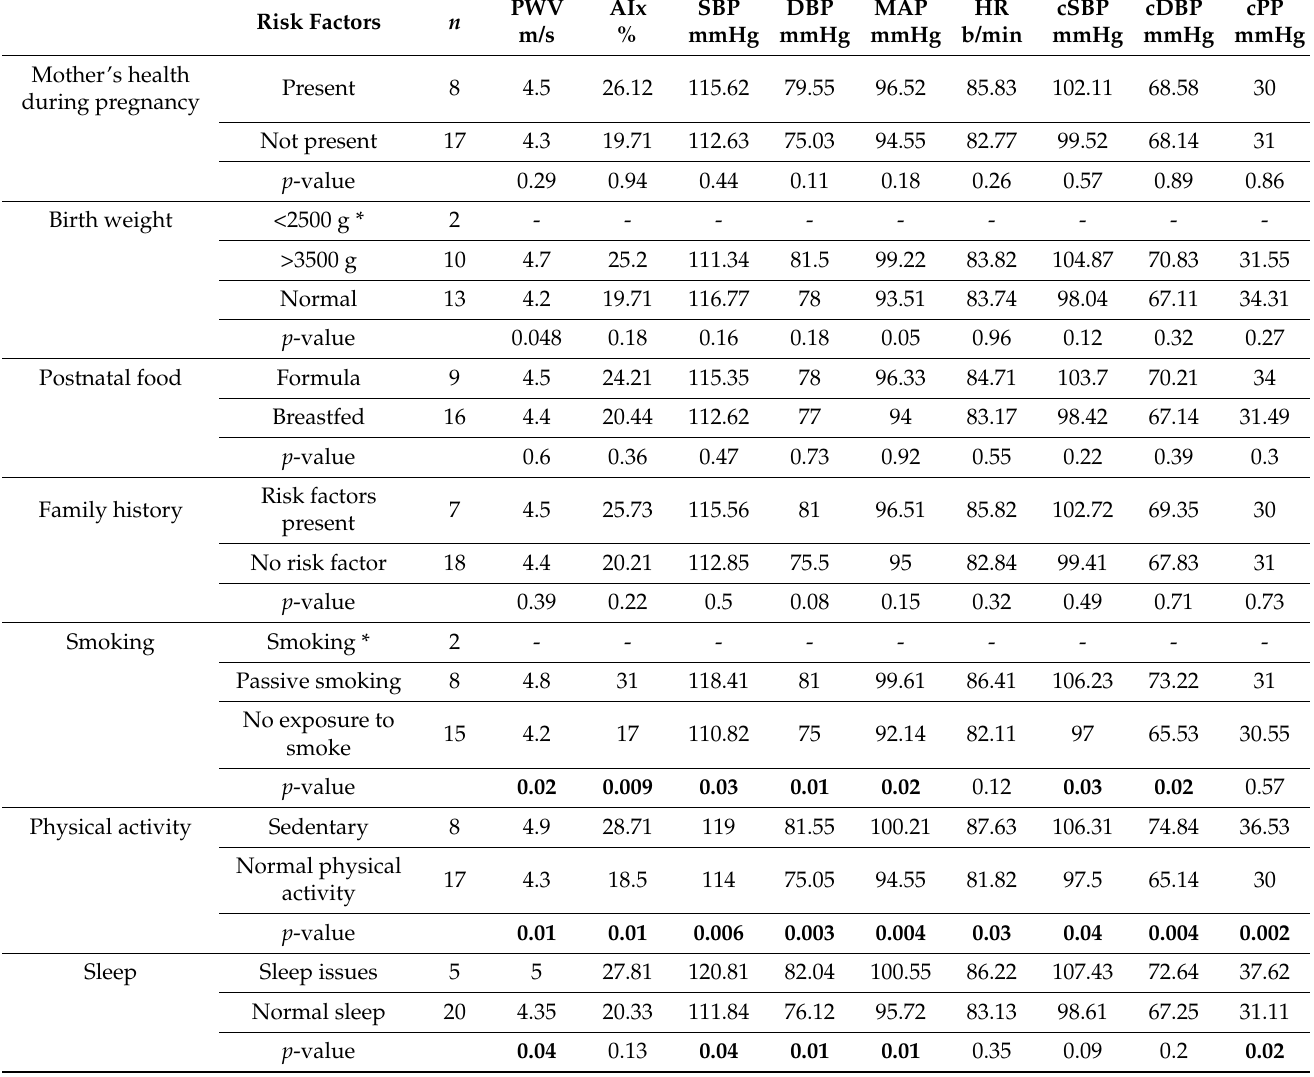
Table 15. PWA parameters comparison of mean/median values depending on the presence of risk factors in the normal-weight group ( t -Student tests and Mann–Whitney tests, after checking each parameter’s normality of